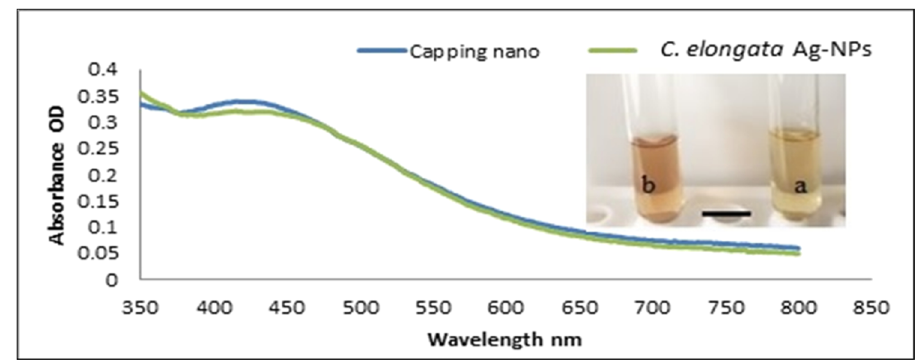
Figure 1: UV - Vis spectrum of AgNPs biogenic by C. elongata , AgNPs coated by acetic acids and AgNPs. Inset shows the color of ( a ) AgNPs capping by acetic acid and ( b ) AgNPs biogenic by C. elongata .